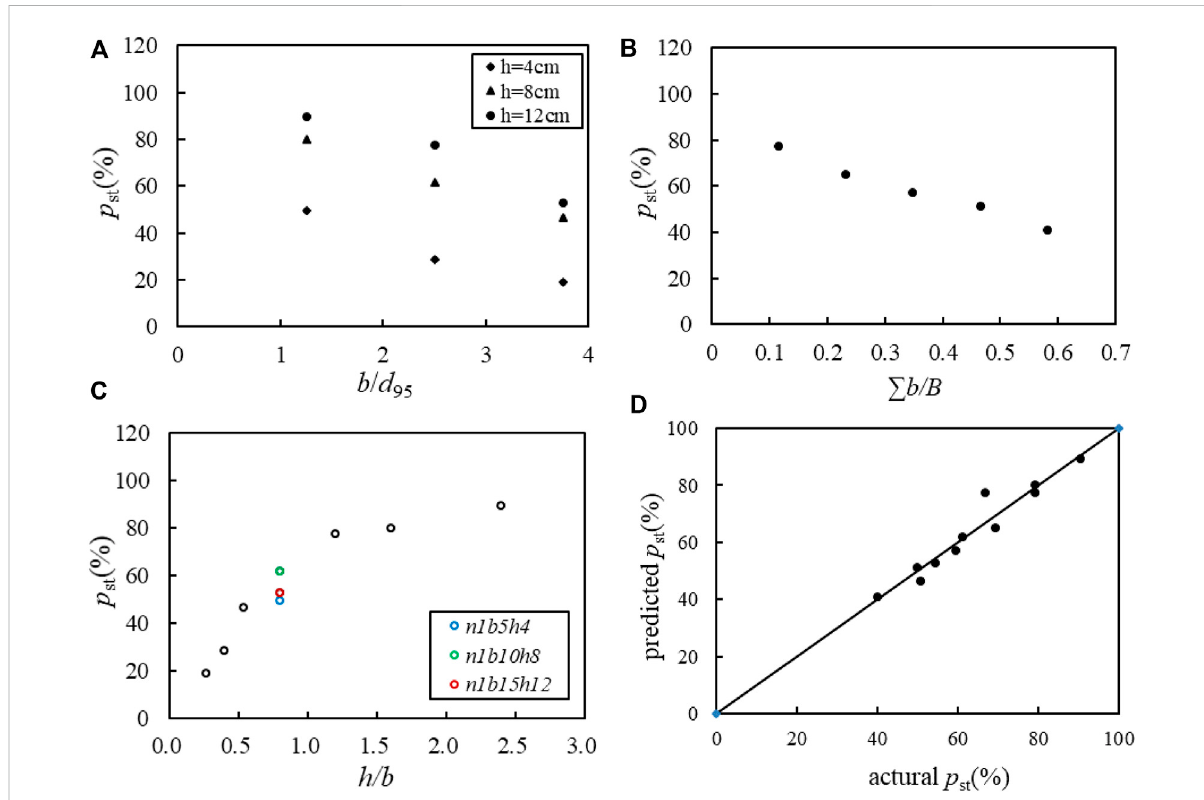
Figure 12C indicates that the sediment trapping rate increased with an increase in the height-to-width ratio. The sediment trapping rate increased dramatically when h/ Figure 12C also demonstrates that the sediment trapping ef fi ciency was different under the same height-to-width ratio conditions. For example, when b 1 =5 cm, h 1 =4 cm, b 2 =10 cm, h 2 =8 cm, and b 3 =15 cm, h 3 =12 cm all satis fi ed the condition of h/b =0.8, then the sediment trapping rate appeared the largest when b =10 cm, h =8 cm. The main reason was that under the condition of n 1 b 5 h 4, a serious over fl ow